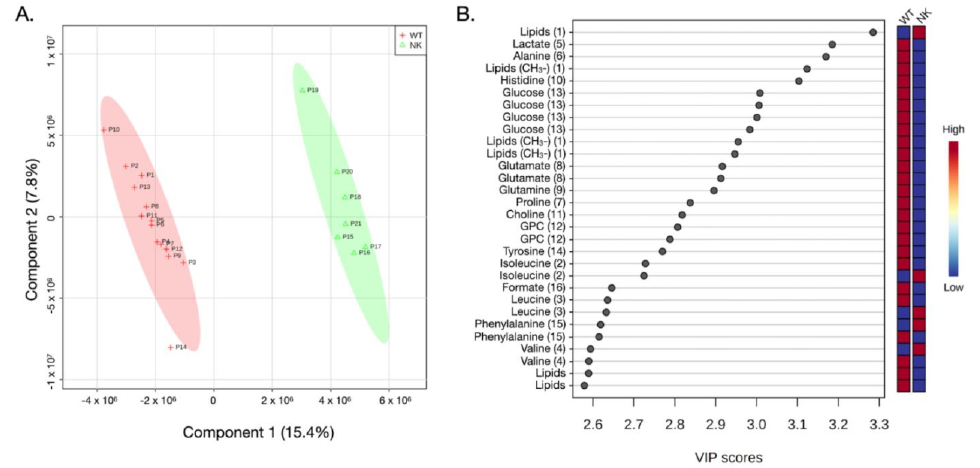
Figure 2. ( A ) PLS-DA score plot in 2D of the HR-MAS 1 H-NMR CPMG data, showing 21 tissue samples, 14 WT and 7 NK. The WT tissue samples are shown with the red crosses and the normal kidney (NK) tissue samples are shown with green triangles. Accuracy: 0.877, R 2 : 0.690, and Q 2 : 0.577. ( B ). Variable importance in projection (VIP) scores greater than 2.5 show the important metabolites (1–16 as illustrated in Figure 1) that are discriminatory for WT vs. NK in the PLS-DA model.